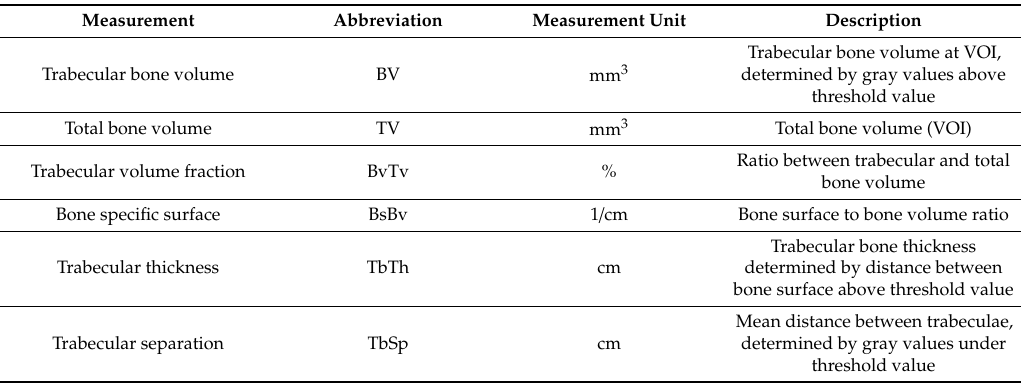
Figure 2. Segmentation of trabecular bone. Green and blue regions represent trabecular bone with ( a ) µCT segmentation and ( b ) magnetic-resonance-imaging (MRI) segmentation, respectively. Table 1. Bone measurement parameters.